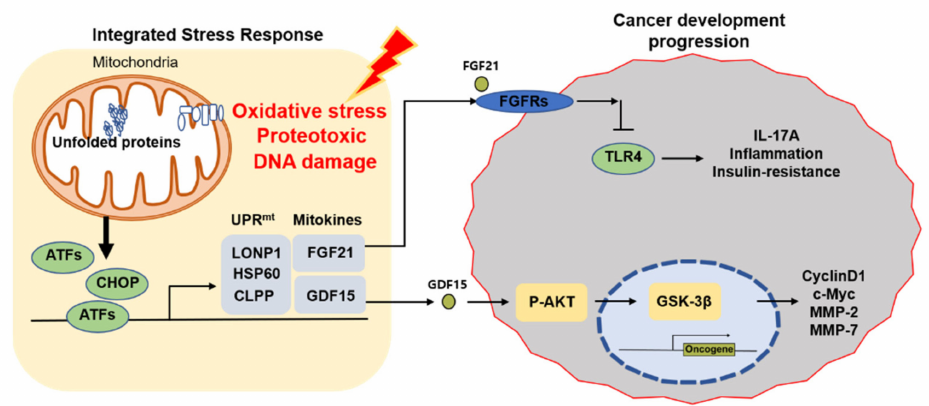
Figure 1. The role of UPR mt and mitokines in cancer progression. When mitochondria are under stress, OXPHOS perturbations, ROS production, and the level of unfolded proteins increase. Increased expression of proteases (ClpP & LONP1) and chaperone proteins (HSP60) during UPR mt promotes mitokine (FGF21 & GDF15) expression, which affects tumor development and progression. LONP1, Lon protease 1.